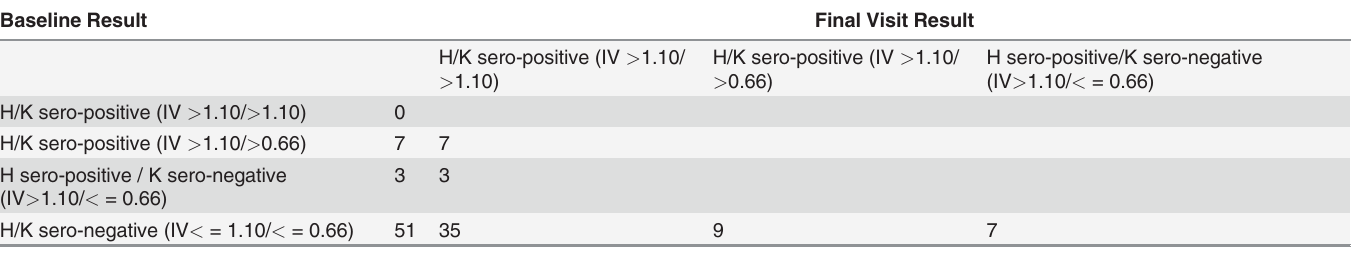
Table 3. Results at baseline and final visit of the HSV-2 seroconverters using the manufacturers cut-off (IV > 1.10) or the lowered cut-off (IV > 0.66). Baseline Result Final Visit